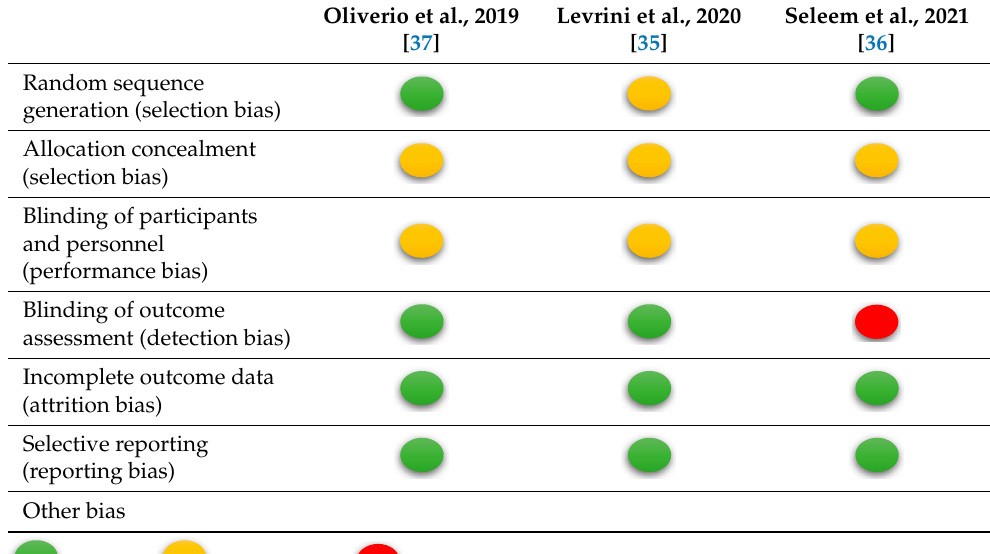
Table 2. Evaluation of the risk of bias in the included studies.